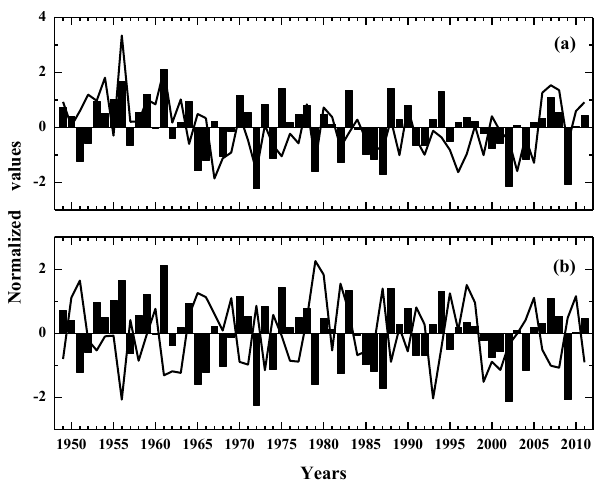
Figure 2. Interannual variability of the normalized values of (a) TI 1 and ISMR and (b) TI 2 and ISMR. Index one and Index two are shown by solid curves while ISMR is shown by